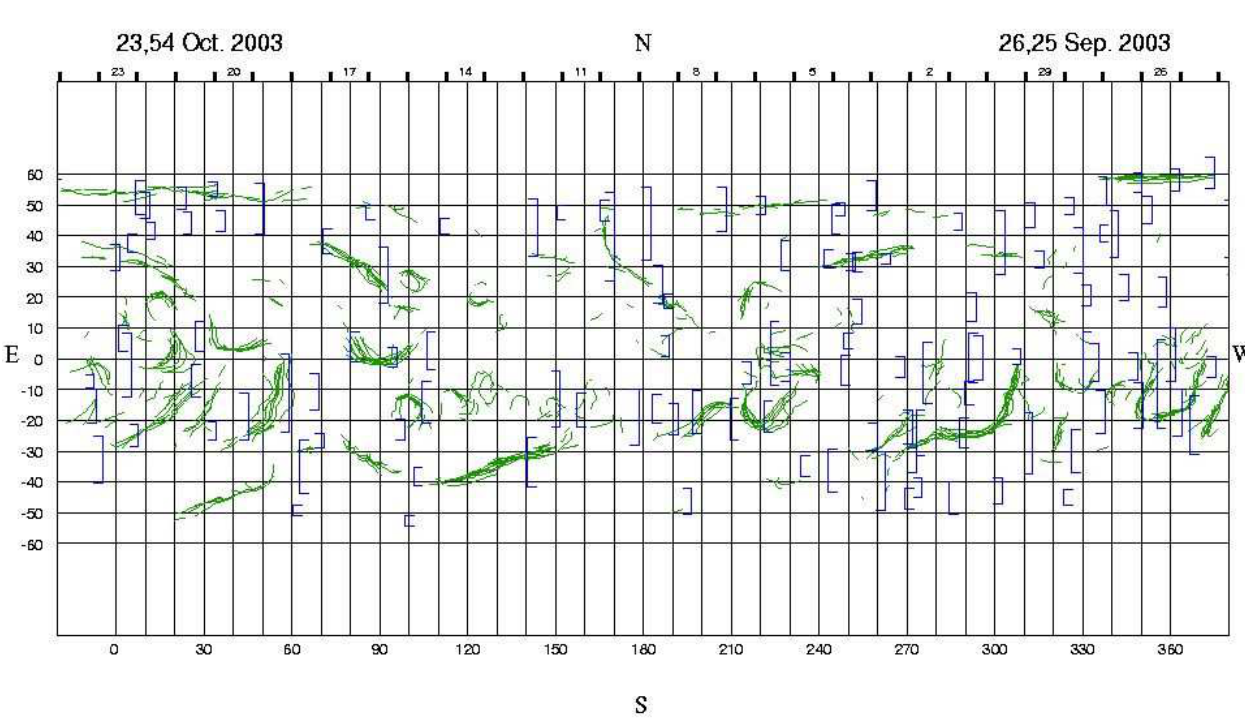
Fig. 3. Example of a Meudon Synoptic Map dedicated to filaments. Each stroke corresponds to the daily position of each filament. The drift or bending of any filament can be directly seen on this map. The blue square brackets correspond to filaments observed off the limb, which are not considered in this article. See text for details.